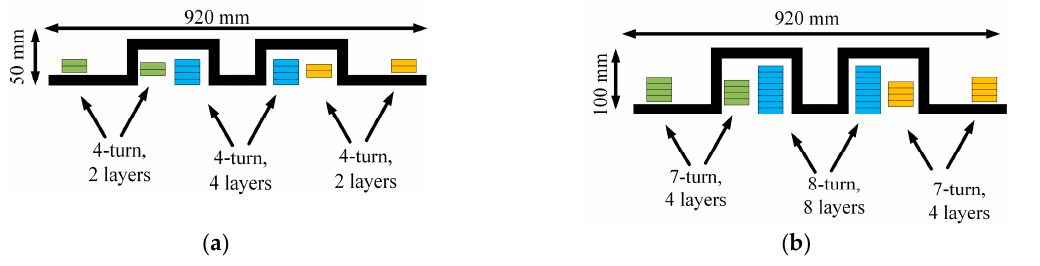
Figure 6. Comparison of the new and the previous pick-up design: ( a ) new pick-up design for 60 kHz operation; ( b ) previous pick-up design for 20 kHz operation.